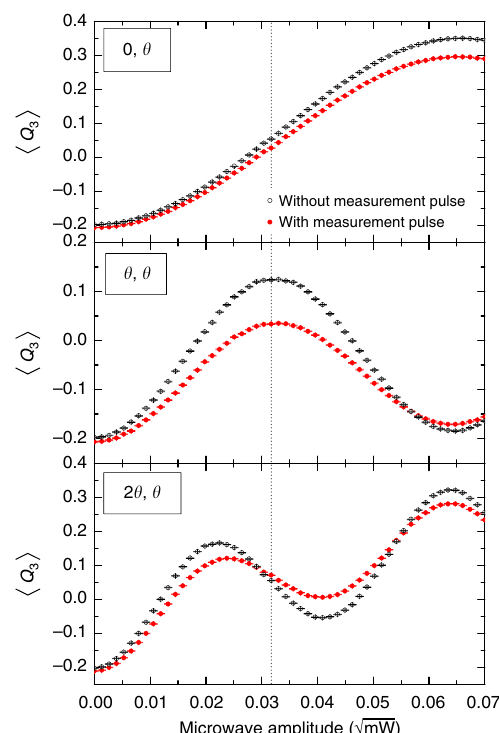
Figure 3 | Control pulses. To measure d g , d r , d e , the control circuitry of our system was arranged in three separate experiments so that the pseudo-spin rotation angles of S 1 and S 2 were, respectively (0, y ),( y , y ),(2 y , y ) for a range of angles y . We then selected the data corresponding to y ¼ p /2, (c.f. Fig. 1b,c) which corresponds to a certain microwave pulse power (shown with a dotted vertical line). Error bars correspond to a 95% confidence interval. The microwave amplitude shown is at the signal generator (it is attenuated before reaching the flux qubit). For quantum mechanical curves, see Supplementary Note 2 and Supplementary Fig.